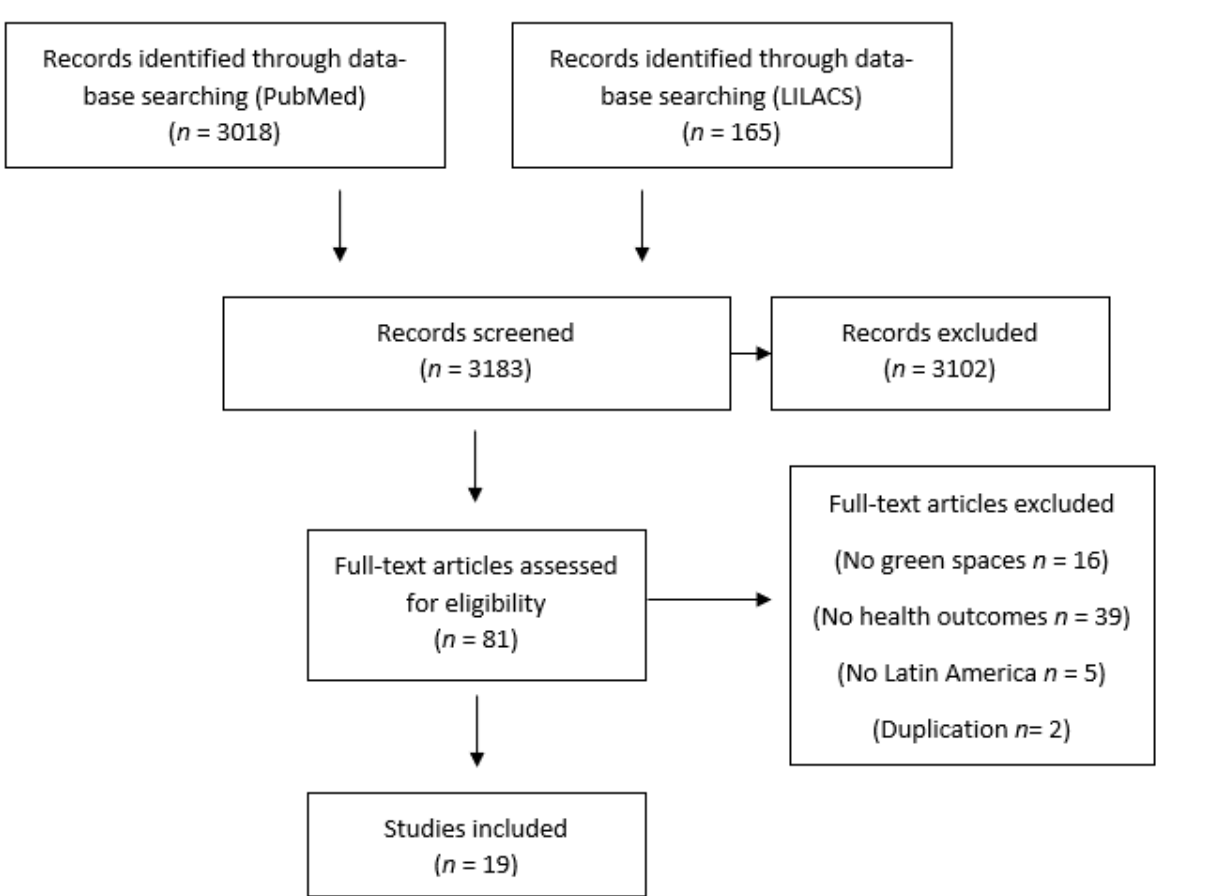
Figure 1. Flow chart of the selection process of epidemiological studies on green spaces and health outcomes in Latin America (end-date of search 28 September 2020).